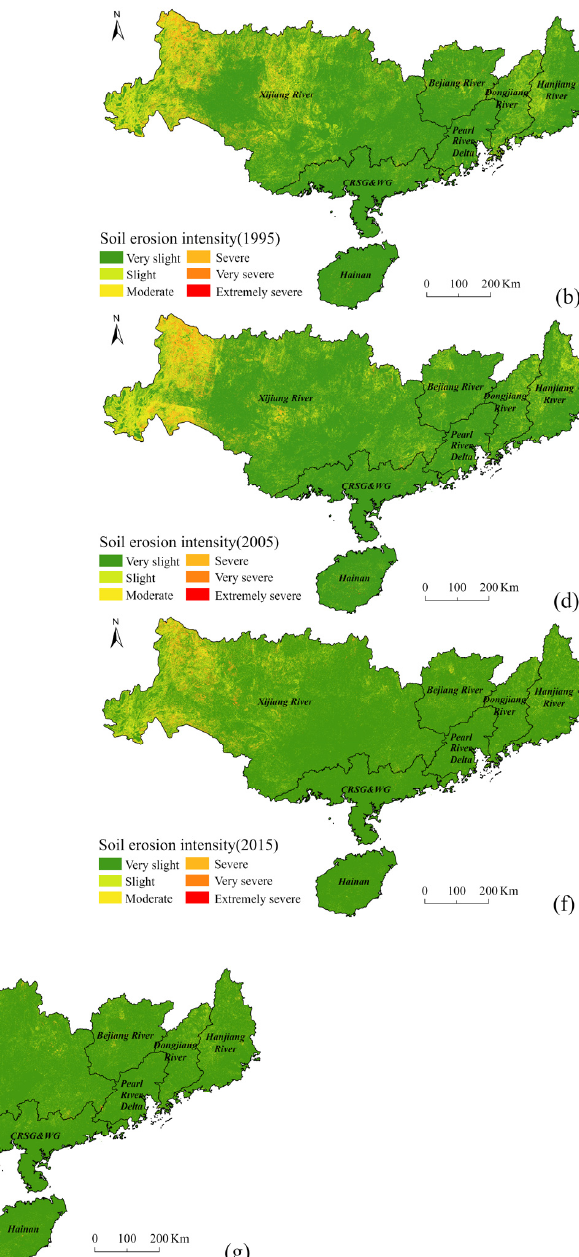
Figure 4. Scatter plot of soil erosion rate from 1990 to 2020 (except 2012). The green dots represent soil erosion rate , the red curve is a linear fit line, and the gray band is a 95% confidence band. Please note: In 2010, soil erosion could be overestimated due to the cloud effect. The XRB was the tributary basin with the highest soil erosion (Figure 5a). Over the past 30 years, soil erosion in the XRB significantly decreased with an annual rate of − 17.96 t/(km 2 ·a). The BRB and DRB were also the sub-basins with relatively high soil erosion, where the fluctuation directions of soil erosion rate were similar to the overall trend after 2011. HRB was another basin with relatively high soil erosion (Figure 5b). From 1990 to 2020, the soil erosion rate in HRB declined from 353.74 t/(km 2 ·a) to 138.71 t/(km 2 ·a), with a relative reduction of 60.79% and an annual decreasing rate of 8.3 (±1.84) t/(km 2 ·a). Li et al. [63] reported that vegetation coverage in HRB increased from 2002 to 2009 due to China’s Returning Farmland to Forest Program, which effectively alleviated soil erosion